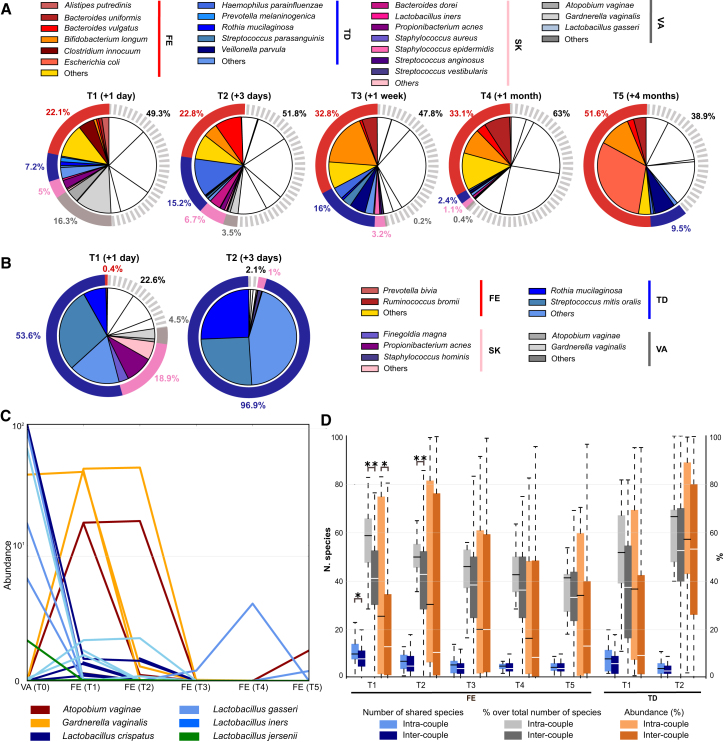
Microbial Species Common to the Mothers and Their Infants(A and B) Average taxonomic composition of the infant stool (A) and tongue dorsum (B) microbiomes over time. The colored sectors indicate species that are found in the infant and his/her mother. White portions refer to species not found in the maternal body sites. External rings show the cumulative abundance of bacterial species per maternal body site.(C) Relative abundances of the most abundant vaginal bacteria in the mothers and in the gut of their infants. Each line represents a mother-infant pair.(D) Number, percentage over total number, and cumulative abundance of identified microbial species that are shared between each mother and her own infant (intra-pair), and between each mother and unrelated infants (inter-pair) (∗p < 0.05 and ∗∗p < 0.01, t test).